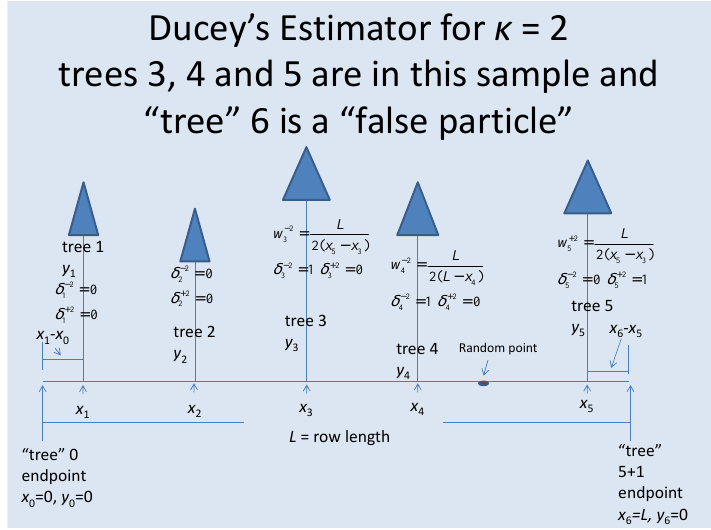
Figure 2. Ducey’s unbiased row sampling estimator with κ = 2, with ˆ Y D . Equation (6) is used to select two trees on each side of the gap into which the randomly located point, z , falls, one of which is a “false particle” at the line